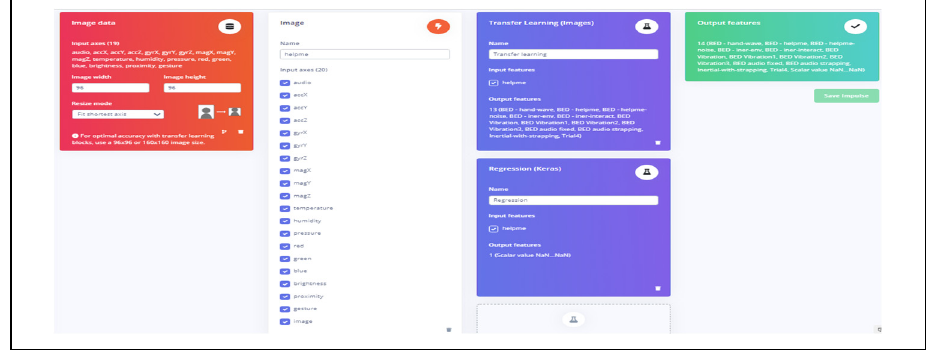
Figure 27. Additional “learning blocks” (TL, KERAS, NN) provided to improve outcomes.